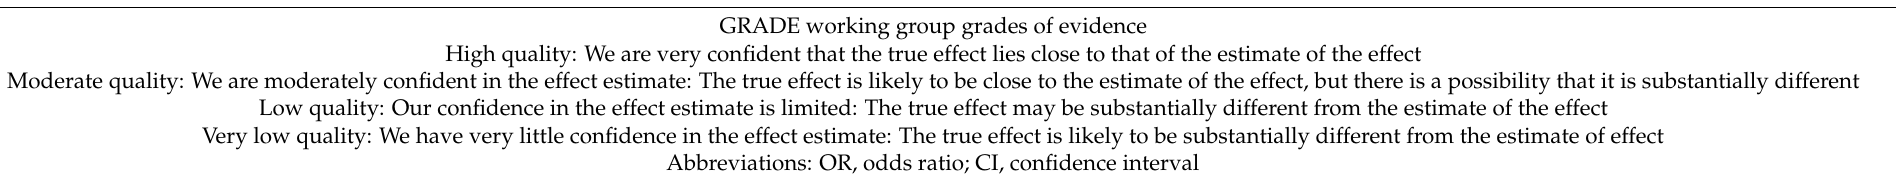
Abbreviations: OR, odds ratio; CI, confidence